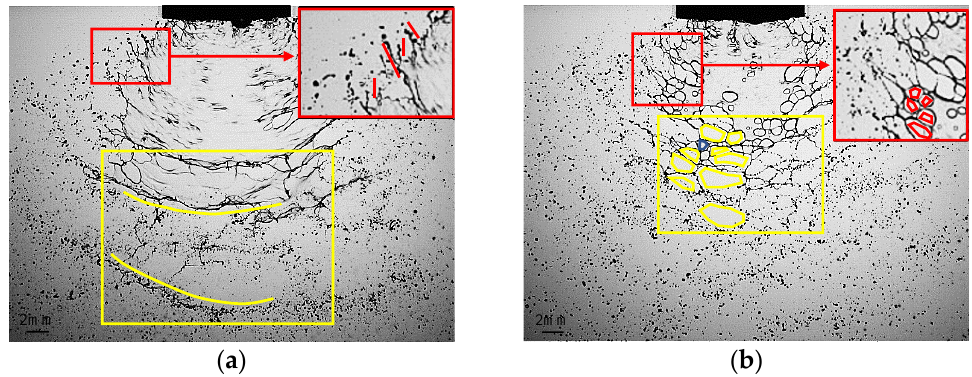
Figure 4. Water ( a ) and emulsion ( b ) atomisation process and rim recession in XY plane. The difference between the two liquid sheet atomisation processes is marked by yellow frame; the difference between two rim recessions is marked by red frame.